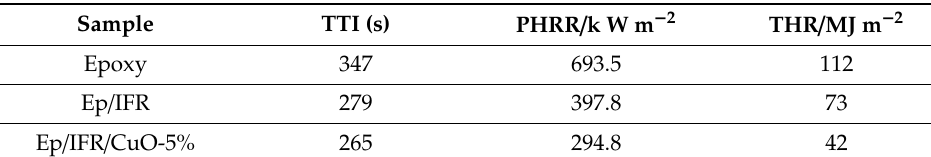
Table 5. Cone-calorimetric results of the coatings.